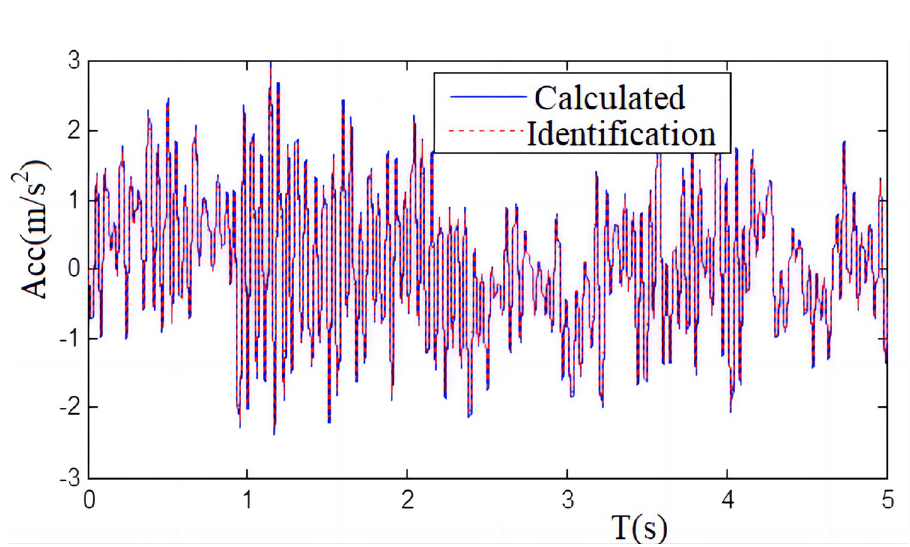
Fig 11. Output displacement of identification compared with the calculated value.